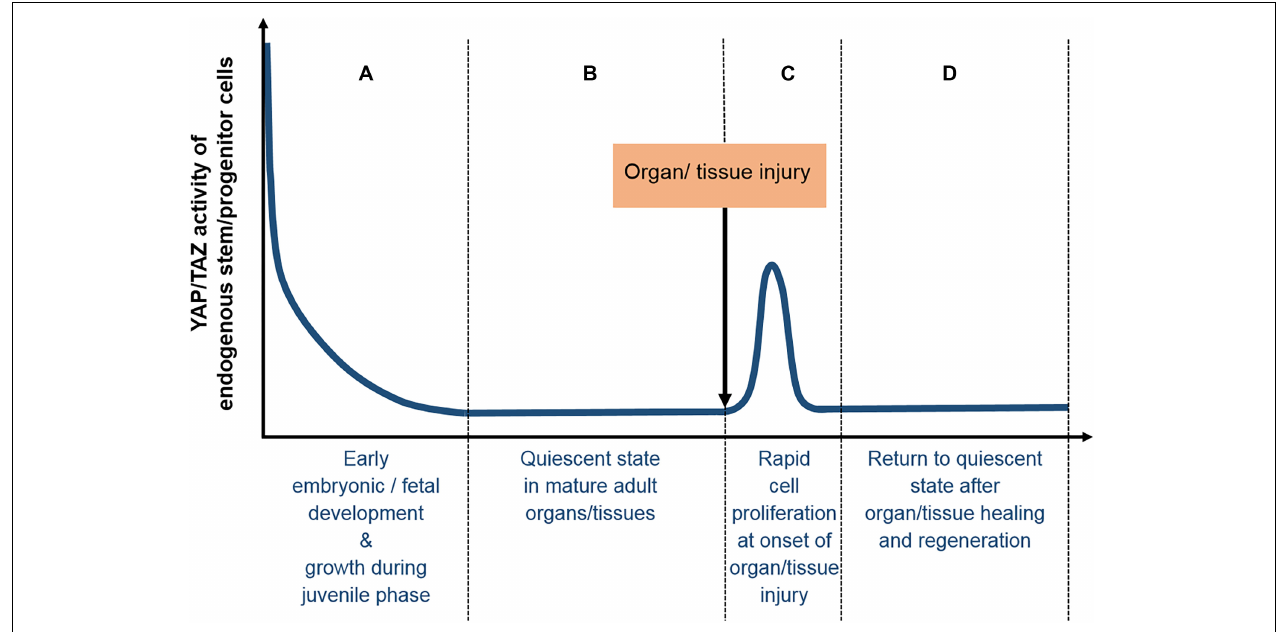
FIGURE 4 | Typical YAP/TAZ expression profile in tissues/organs during normal development and homeostasis. (A) Early embryonic and fetal development are typically associated with high levels of YAP/TAZ activity, which are gradually downregulated after birth, as growth during the juvenile phase slows down, (B) finally reaching basal levels at the quiescent state of mature adult tissues/organs. (C) At the onset of tissue/organ injury, the mobilization and rapid proliferation of endogenous adult stem/progenitor cells are associated with highly elevated YAP/TAZ expression levels, which (D) return to basal levels of the quiescent state after organ/tissue healing and regeneration is